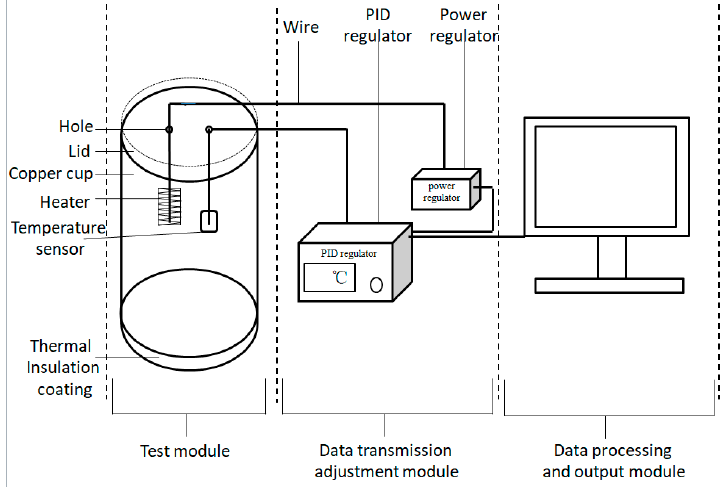
Figure 3. The test equipment for the thermal insulation performance in a low-temperature environment.